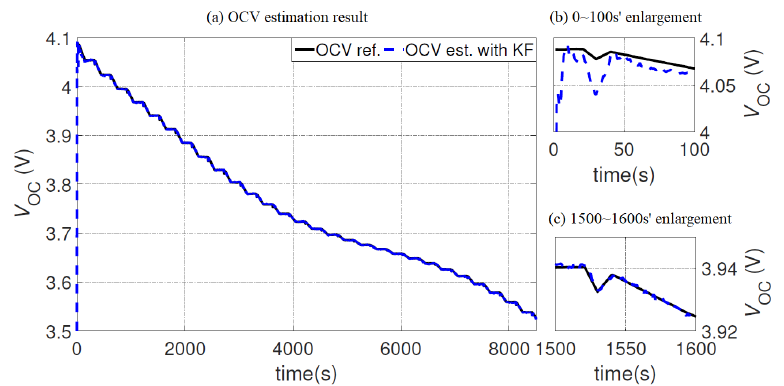
Figure 12. Estimation result of the battery OCV.